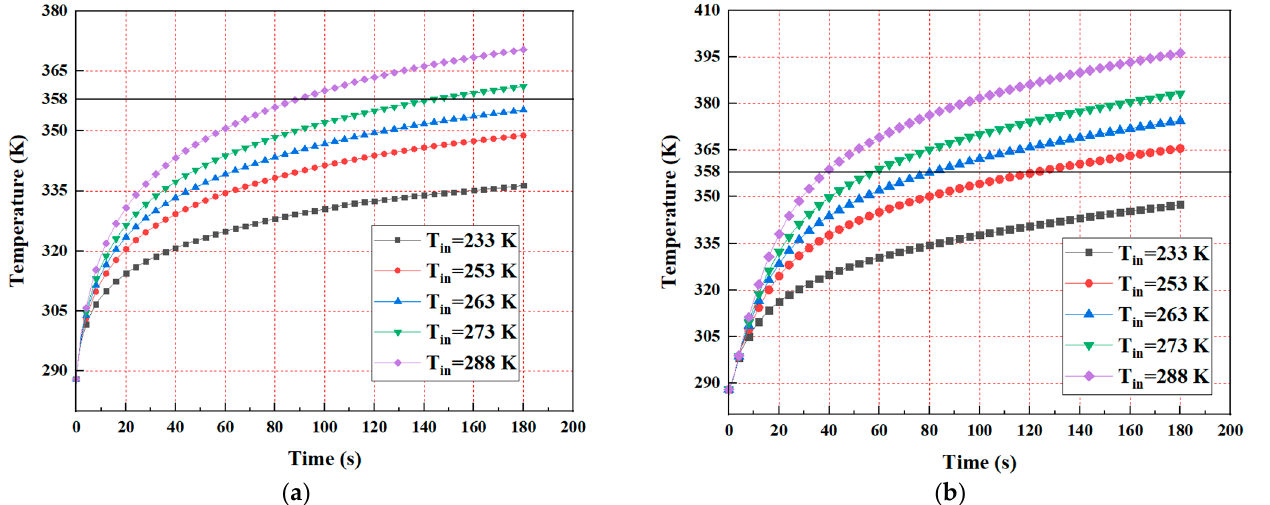
Figure 14. Evolutions of the hydrogen temperature rise for ( a ) Cylinder A and ( b ) Cylinder B at di ff erent inlet temperatures.